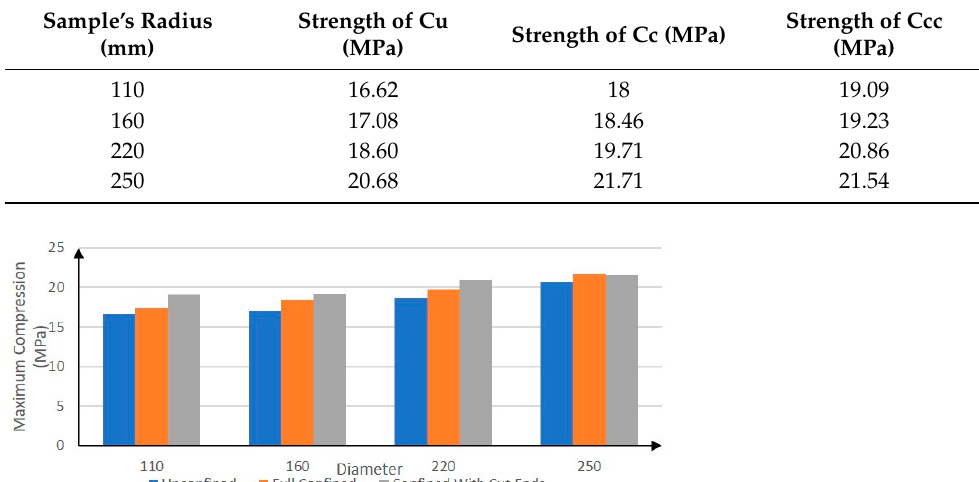
Table 9. Compressive strength at the age of 28 days.